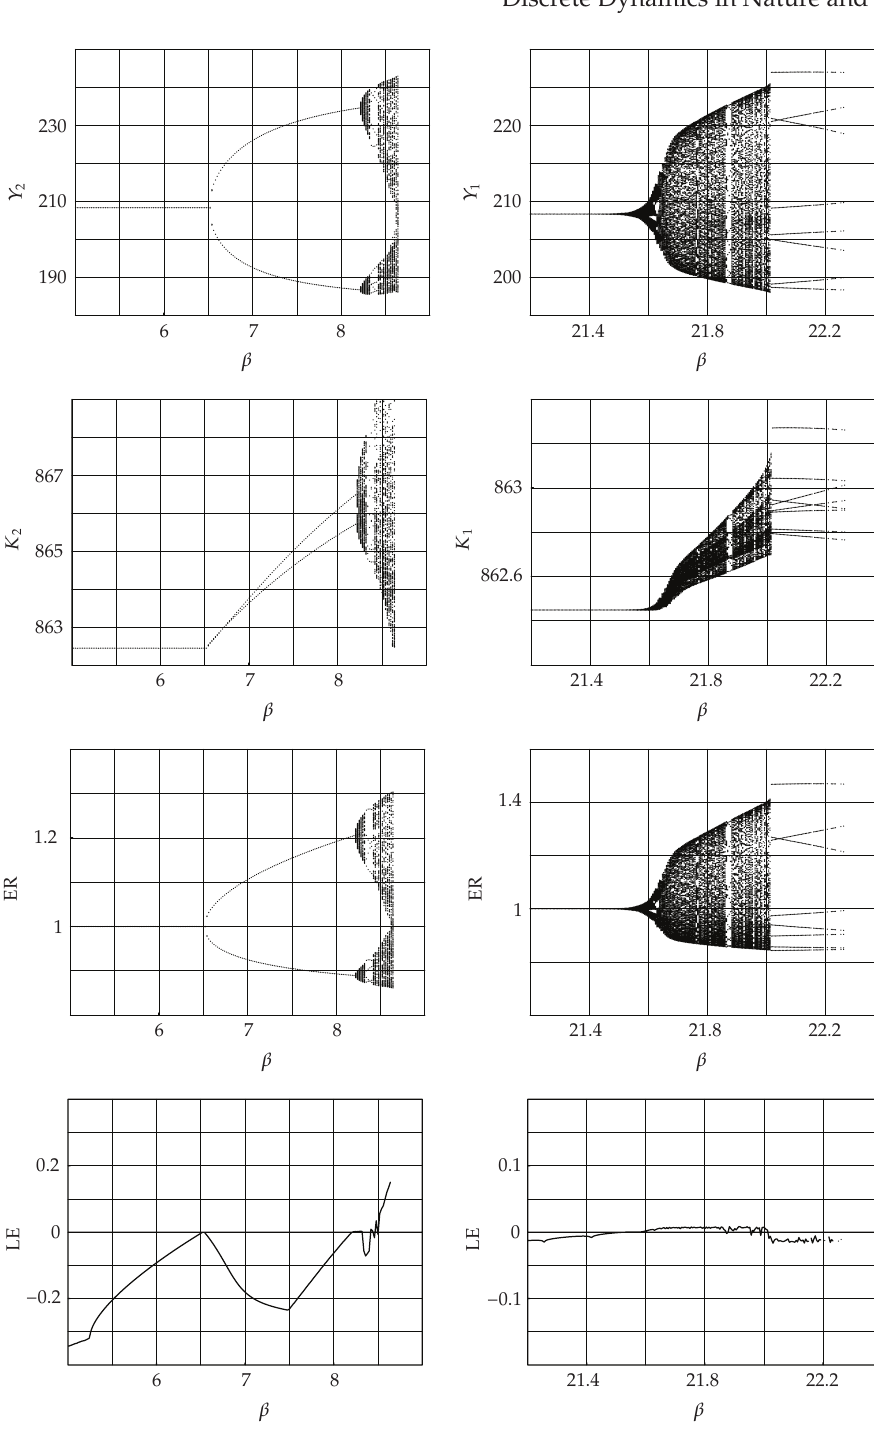
Figure 11: Bifurcation diagrams for γ (cid:9) 1 . 6, δ (cid:9) 0 . 4 , and α (cid:9) 2 . 5 (cid:4) left (cid:7) , α (cid:9) 1 . 5 (cid:4) right (cid:7)